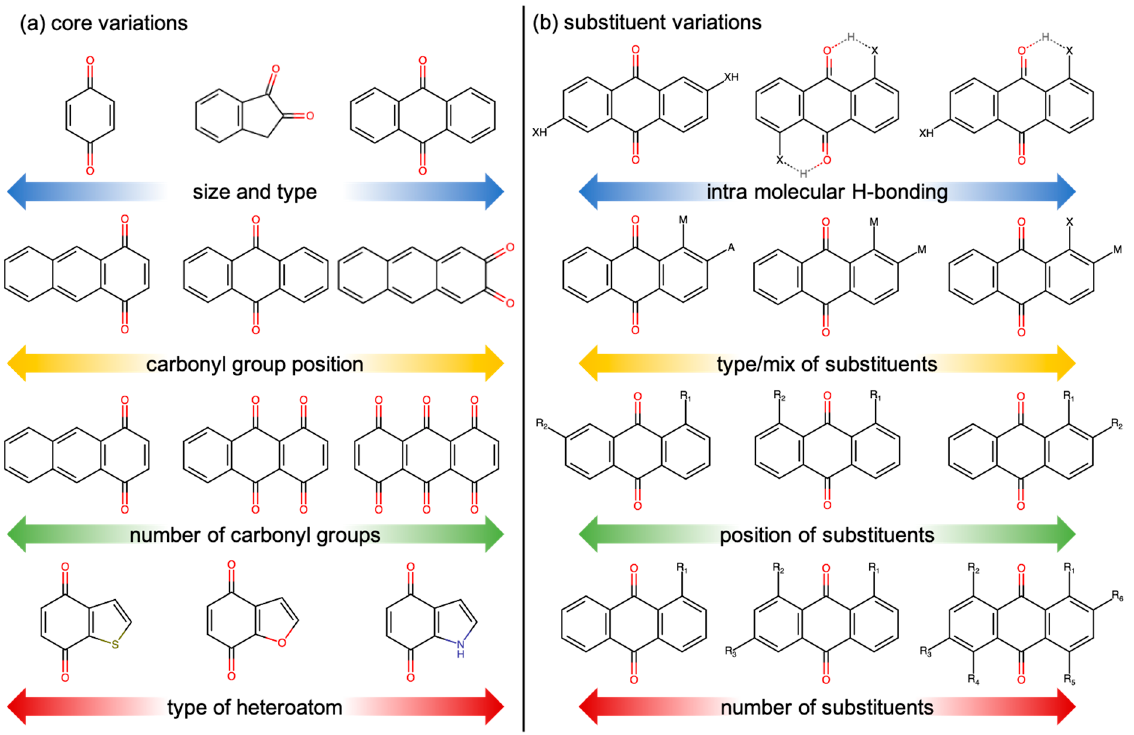
Figure 6. Schematic showing examples of the various structural and configurational degrees of free ‐ dom that are modified when creating a virtual library: ( a ) core variations and ( b ) substituent varia ‐